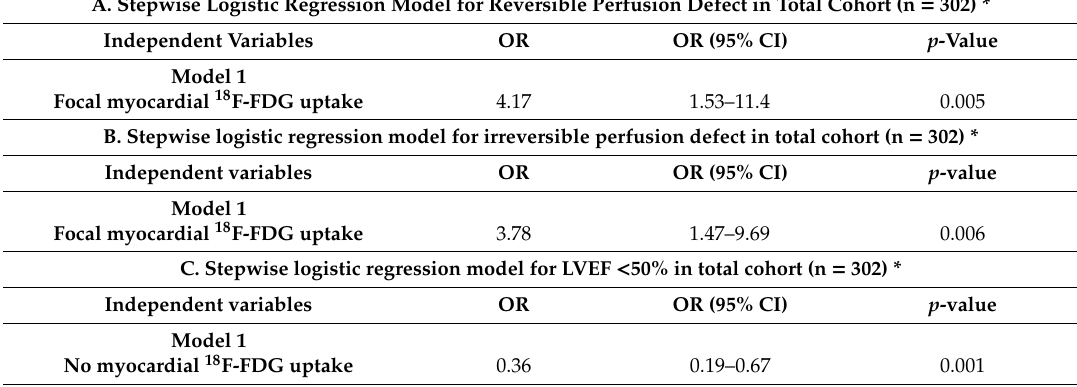
Table 4. Predictive value of 18 F-FDG myocardial uptake pattern for ongoing ischemia, myocardial scar, and left ventricular